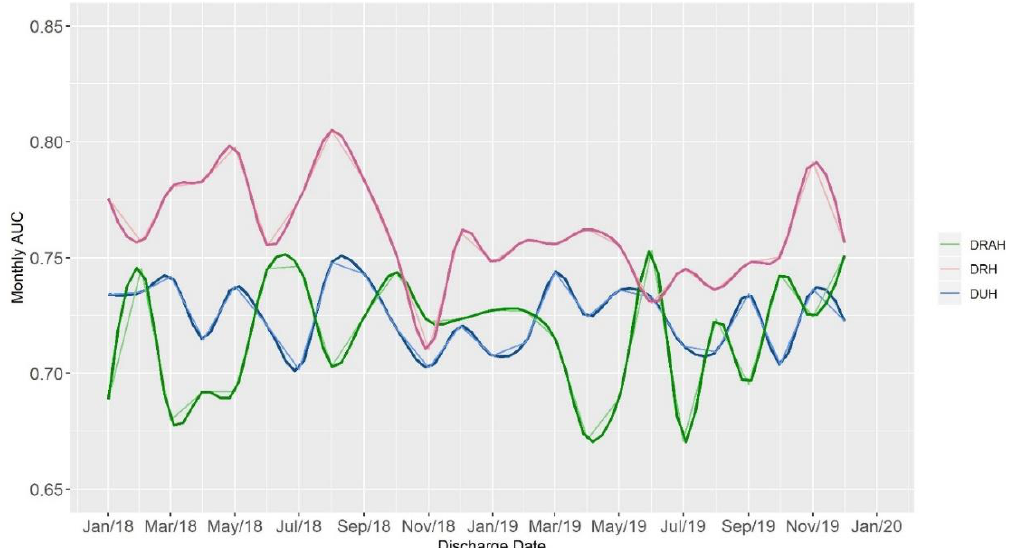
Figure 4. Area under the curve (AUC) over time by hospital. Figure shows LOWESS smooth in bold over time with the unsmoothed data below.